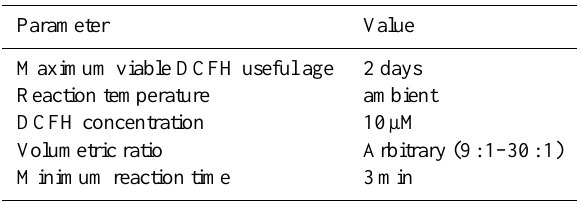
tracted via the port at the bottom of the chamber. Sample air is drawn through the opening in the base of the chamber, nebuliz- ing the liquid inside and creating a mist of droplets. Liquids are retained by means of a hydrophobic filter attached to the top of the mist chamber, which also refluxes liquid back down the sides of the glass. Table 1. Optimal parameters for use in online